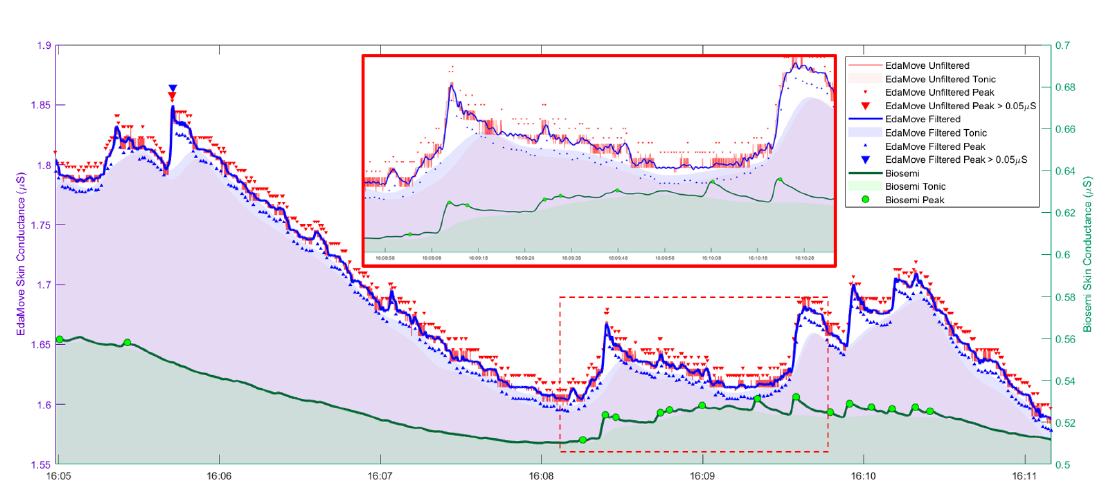
Figure 4. Continuous decomposition analysis (CDA-Ledalab) results from EdaMove signals before and after filtering and from ground-truth ActiveTwo signal. The smaller box illustrates in finer details. Locations of the estimated phasic peaks are shown. Significant peaks with the estimated amplitude higher than 0.05 µ S are highlighted by using larger marks. Note that the scale on the left-vertical axis is for EdaMove signals, while the scale on the right-vertical axis is for ActiveTwo signal.